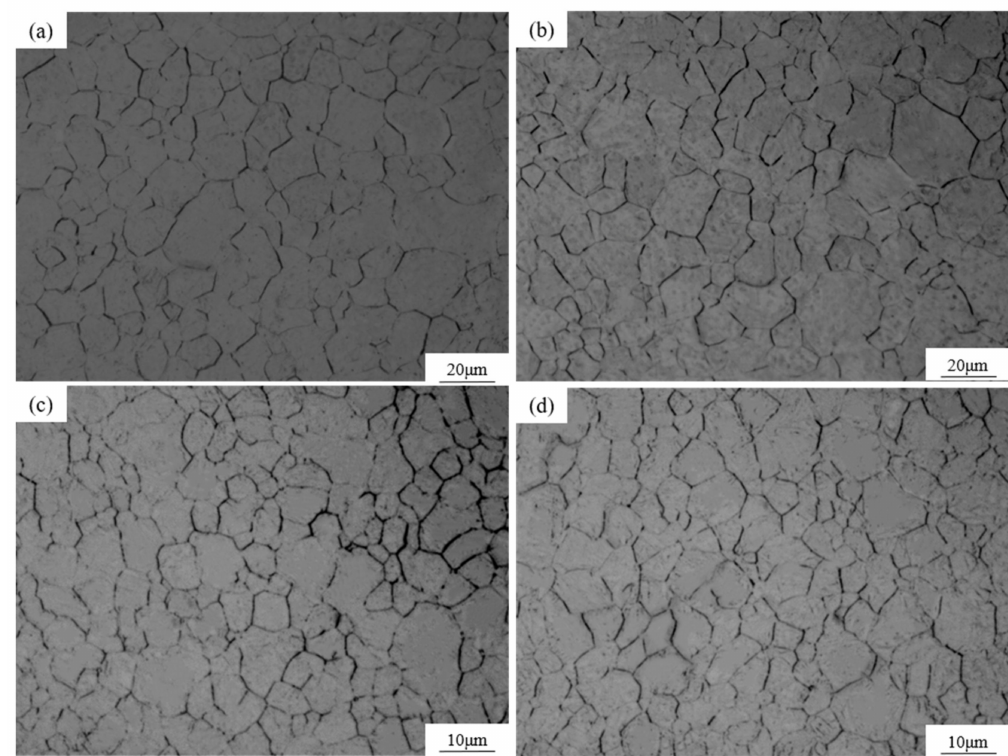
Figure 14. Prior austenite grain morphology of steels observed by OM: ( a ) steel A and ( b ) steel B under conventional heating at 880 ◦ C then air cooled (CHA); ( c ) steel A and ( d ) steel B under flash heating to 880 ◦ C then air cooled (FHA).